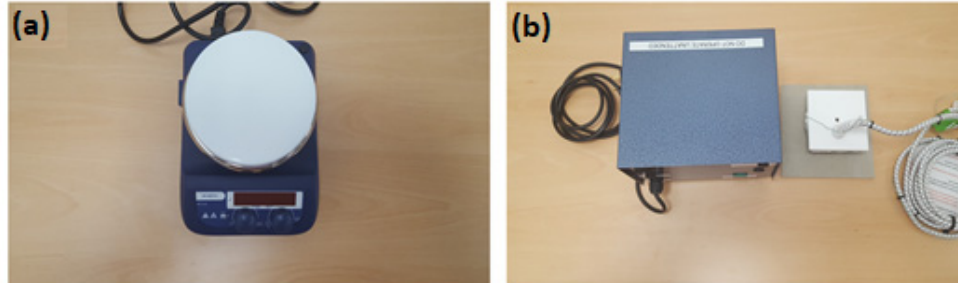
Figure 3. A digital hotplate used for heating the porcine skin samples ( a ) and a heat control device with metal plate used for performing burns on the porcine skin samples ( b ).